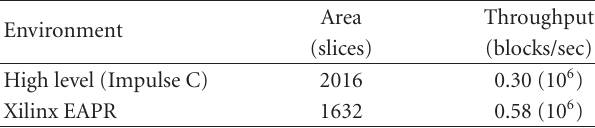
Table 6: Cryptographic application performance benchmarks.